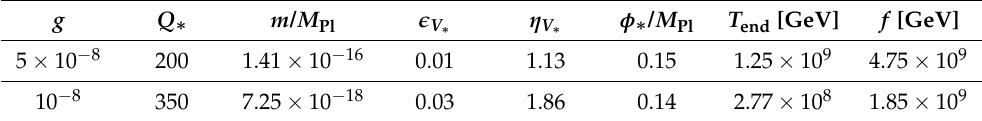
Table 1. Model parameters and relevant quantities obtained from the MWI model with the hybrid inflaton potential. In all cases, we have considered M (cid:38) 2.5 × 10 17 g GeV and λ = 10 − 2 . The number of e-folds N ∗ at Hubble radius crossing is found from Equation (54), and it is N ∗ (cid:39) 49 for the cases shown here. g Q ∗ m / M Pl (cid:101) V